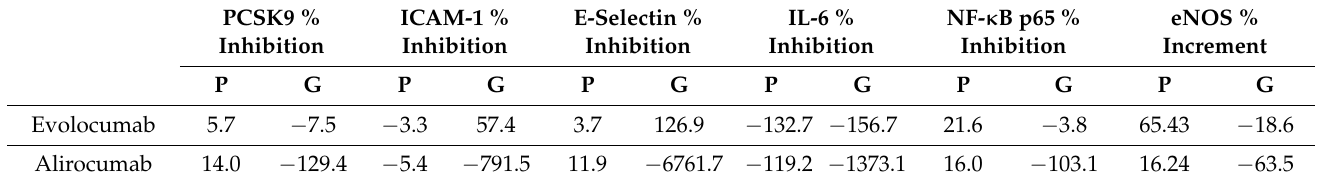
Figure 2. Effects of PCSK9 inhibitors on ( a ) PCSK9, ( b ) ICAM-1, ( c ) E-Selectin, ( d ) IL-6 protein expression in LPS-stimulated HCAEC. Data are expressed as mean ± SD (n = 9). Statistical analysis: ANOVA, post-hoc with Bonferroni correction; * p < 0.05, ** p < 0.01, and *** p < 0.001 compared to HCAEC incubated with LPS alone. Abbreviation: UNT (Untreated), LPS (Lipopolysaccharide). Table 1. Percentage of inhibition of PCSK9, inflammation, endothelial activation, NF-kB p65, and eNOS biomarkers by PCSK9 inhibitors based on area under the curve (AUC) analysis.